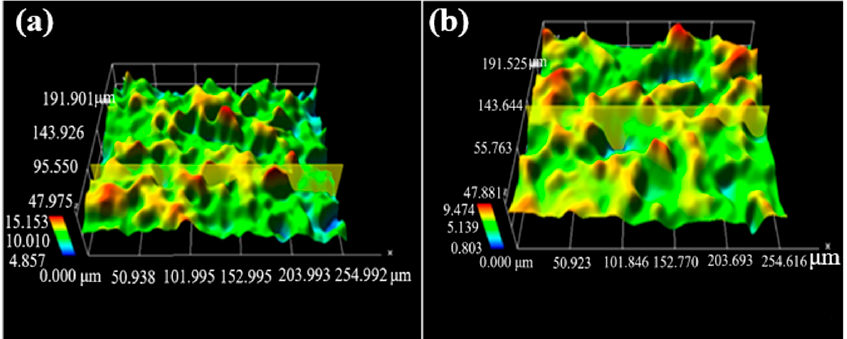
Figure 3. Atomic force microscopy (AFM) results of the implants: ( a ) Ti64/SA implants and ( b ) Ti64/7 ion implants.